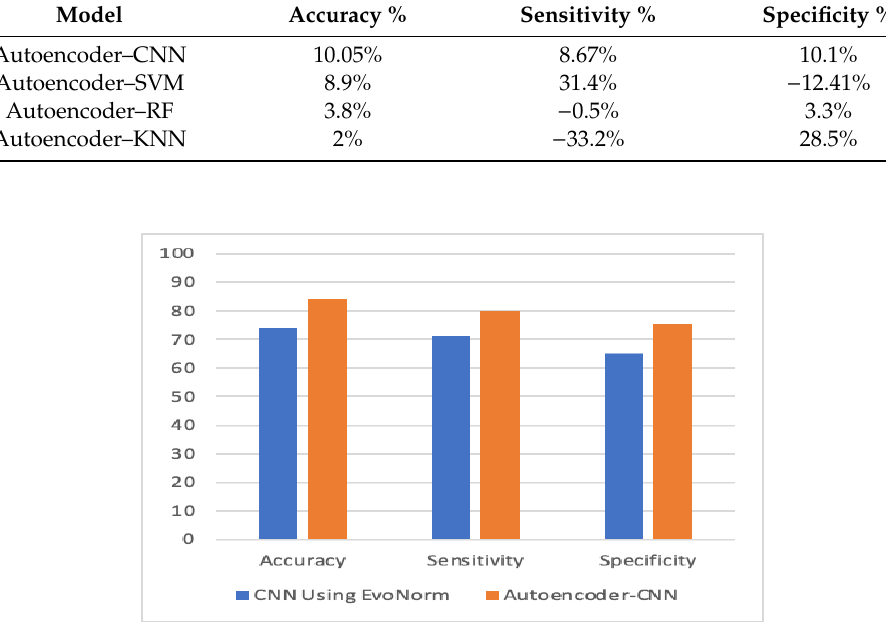
Figure 10. Autoencoder-CNN vs. CNN. CNN: convolution neural network.